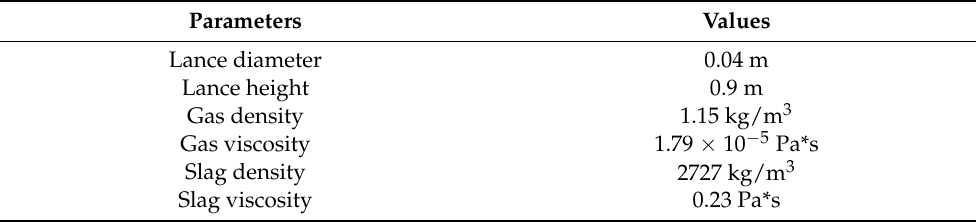
Table 1. The operating parameters selected in the simulation